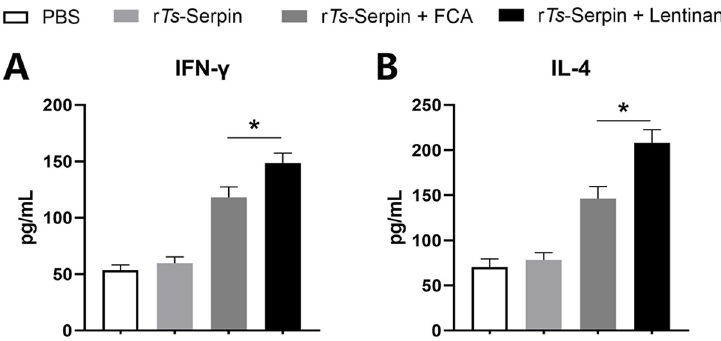
Fig 3. Analysis of cytokine production from CD4 + T cells. CD4 + T cells secreting IFN- γ (A) and IL-4 (B) production was measured by ELISA one week after the final immunization. The data are the mean ± SD of each group (n = 10) from three independent experiments. � p < 0.05 as indicated by the lines (one-way ANOVA with Tukey’s post-test).